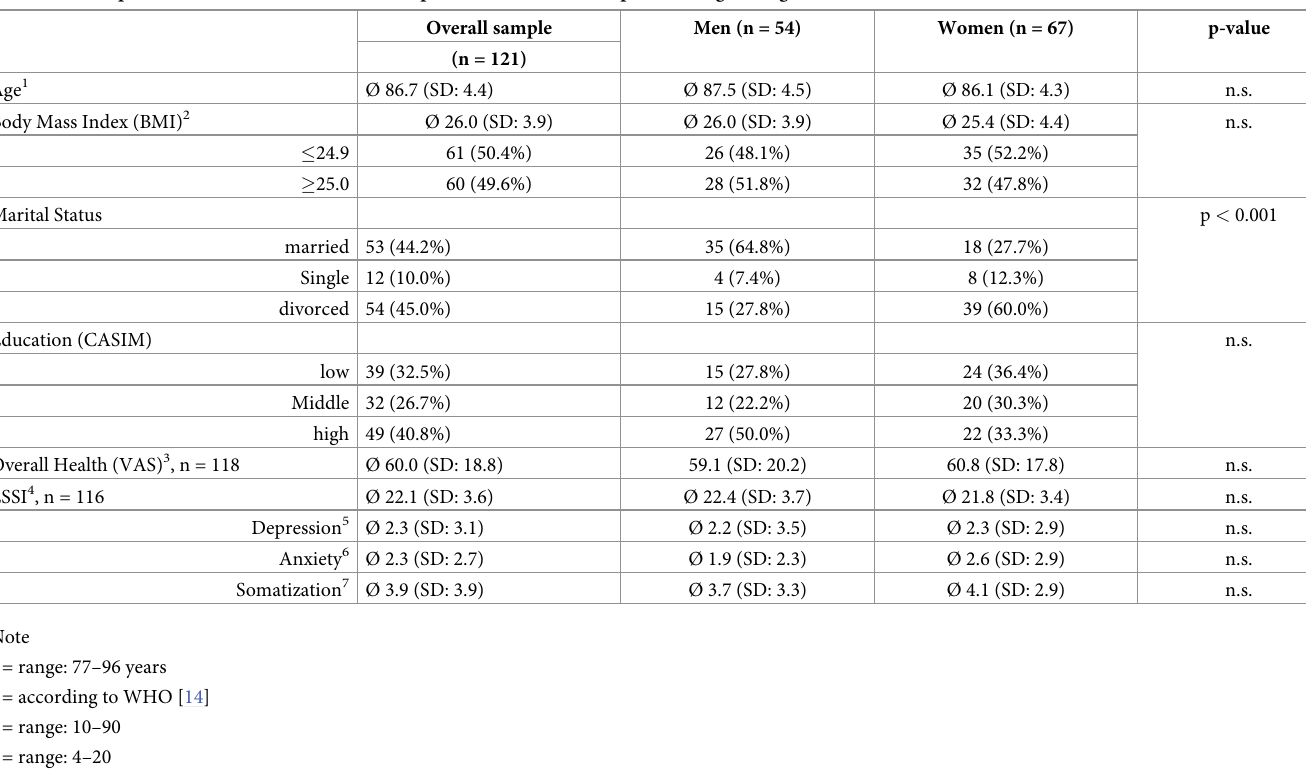
Table 1. Descriptive information on the overall sample and the two sub-samples with regard to